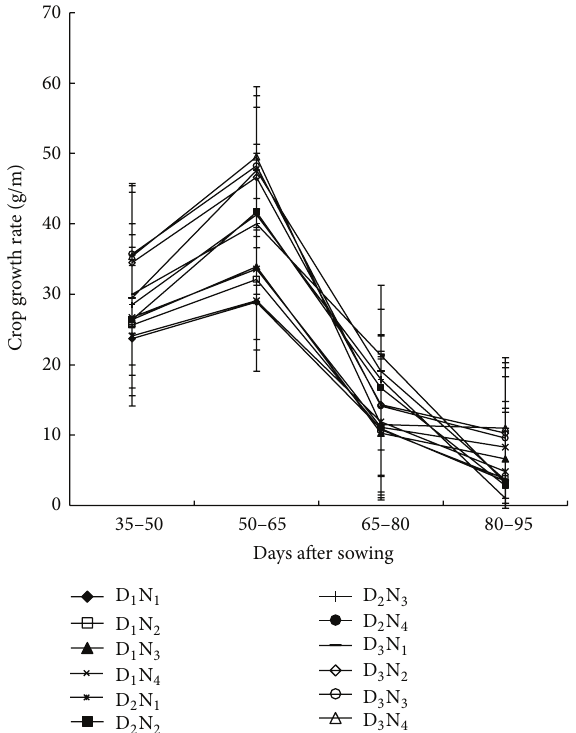
Figure 4: Crop growth rate of maize as affected by N-fertilizer and planting density at different growth stages (D 1 = 53,000 plant/ha, D 2 = 66,000 plant/ha, D 3 = 80,000 plant/ha, N 1 = 100kg N/ha, N 2 = 140kg/ha, N 3 = 180kg N/ha, N 4 = 220kg N/ha. Bar showed ± SE value).